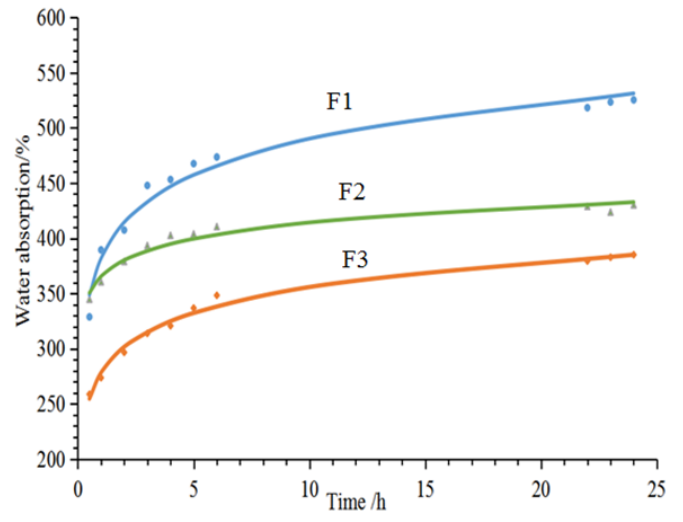
Figure 3. 24-h water absorption of furanic-glyoxal foams.